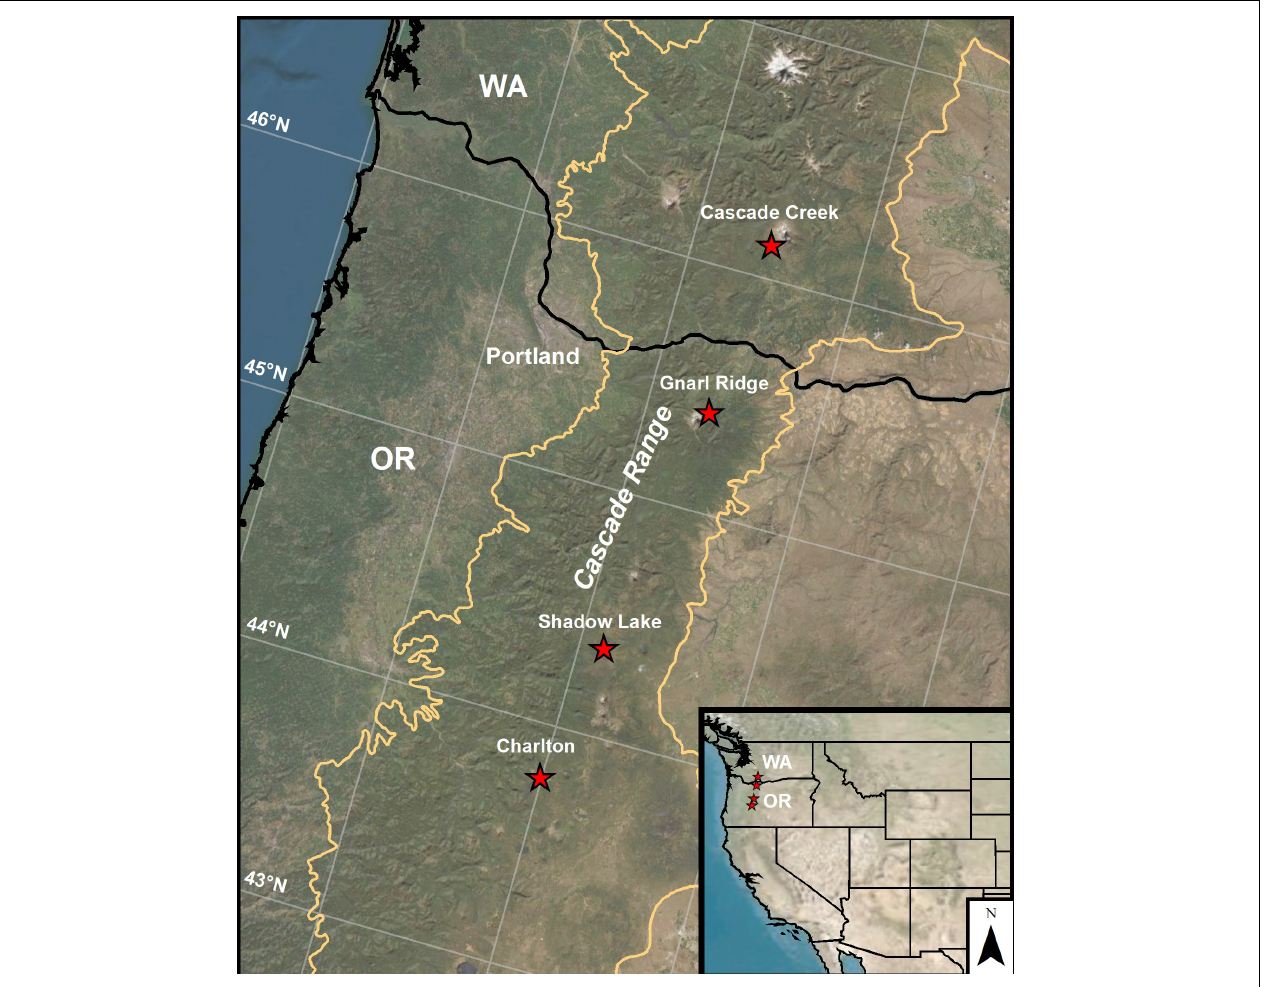
FIGURE 1 | Geographic location of the four wildfires sampled in this study within mesic, high-elevation subalpine forests of the Cascade Crest region of Oregon and Washington states, United